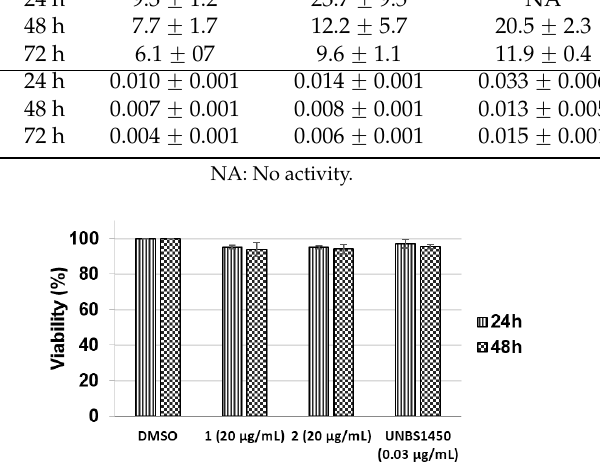
Figure 5. Cytotoxic effect of (1) and (2) at 20 μ g/mL and UNBS1450 at 0.03 μ g/mL on PBMCs (peripheral blood mononuclear cells) for 24 and 48 h. Viability was evaluated by trypan blue exclusion assay. Results are the mean ± SD (Standard Deviation) of three independent experiments.